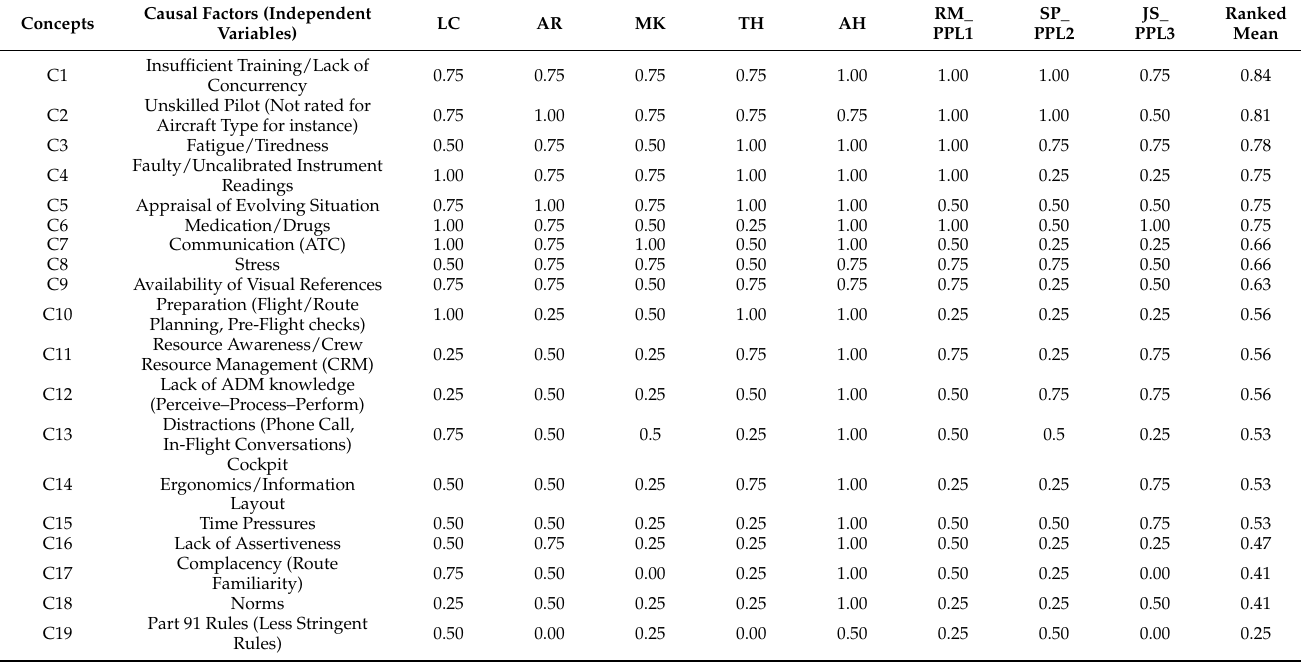
Table 5. HFACS variables aggregated and sorted in ranking as determined by aerospace and aviation